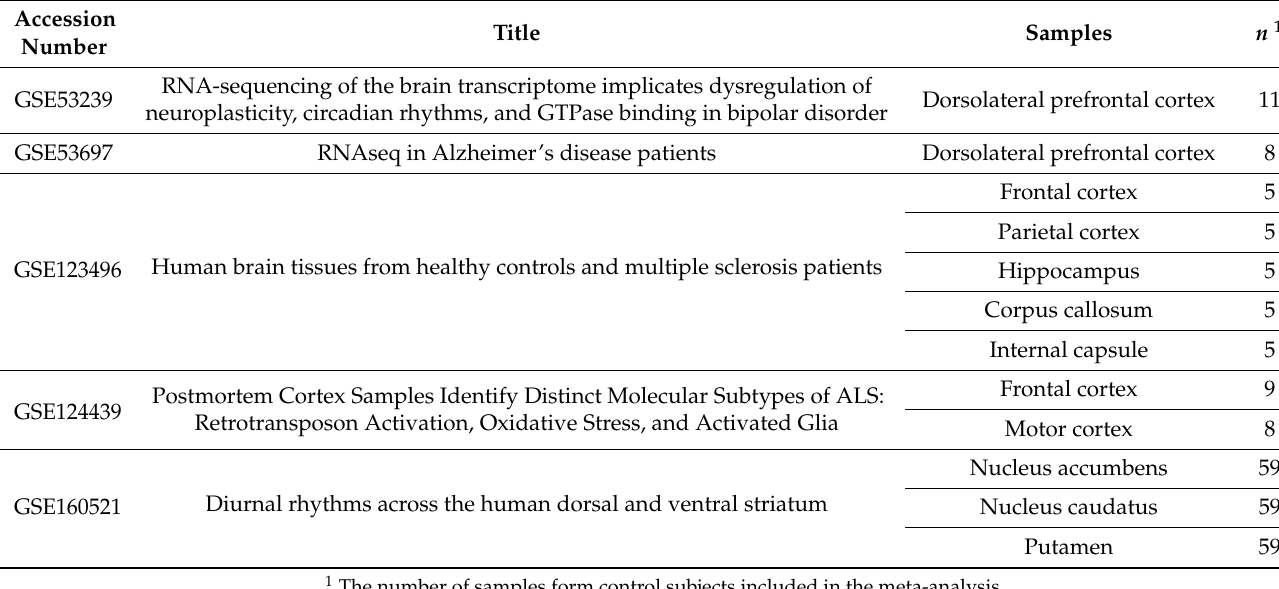
Table 1. Human transcriptomic GEO datasets meeting the inclusion criteria and included in the analysis.